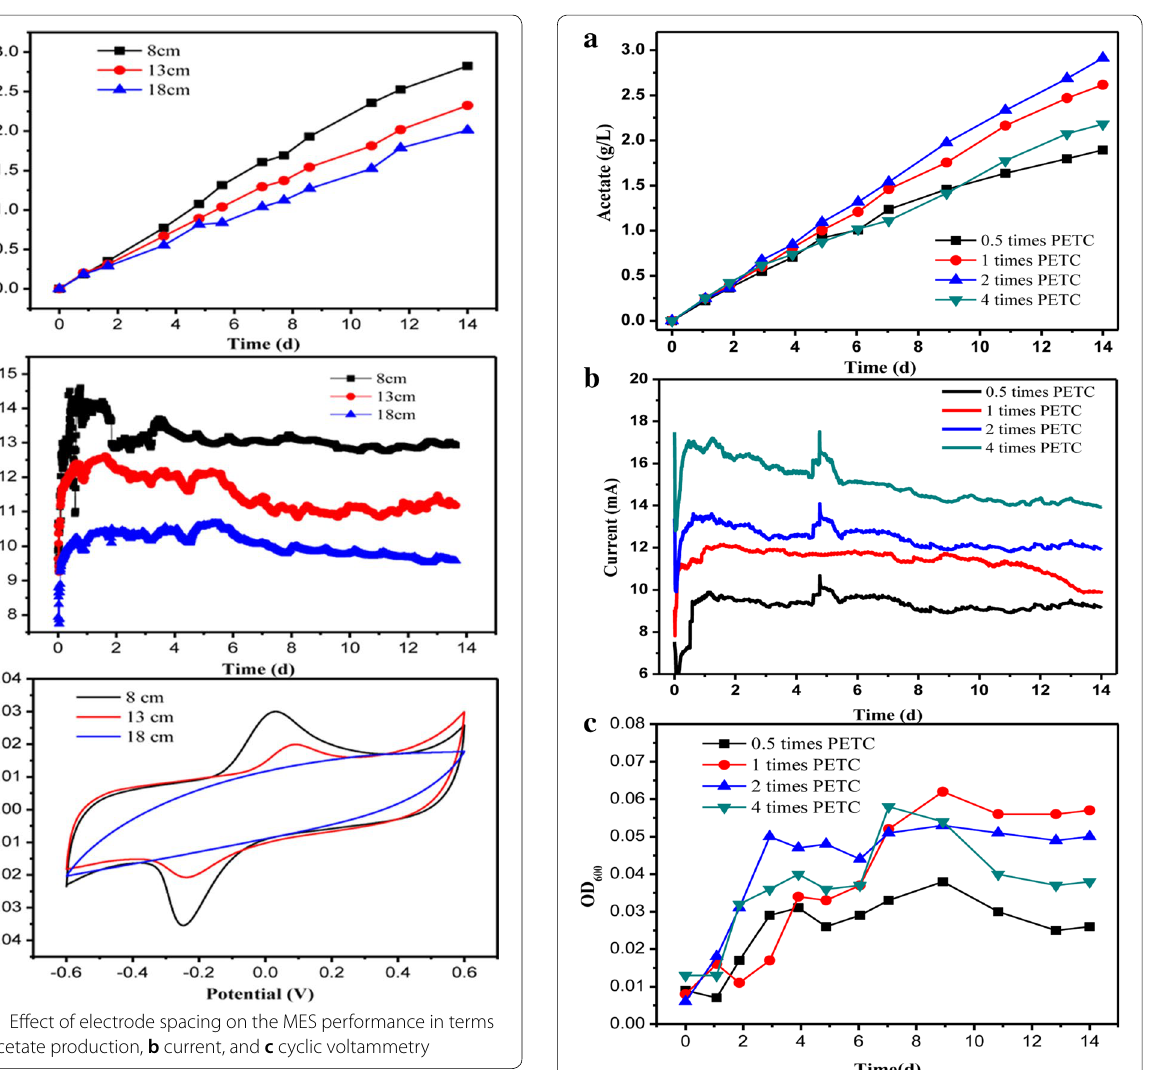
Fig. 3 Effect of PETC on the MES performance in terms of a acetate production, b current, and c OD